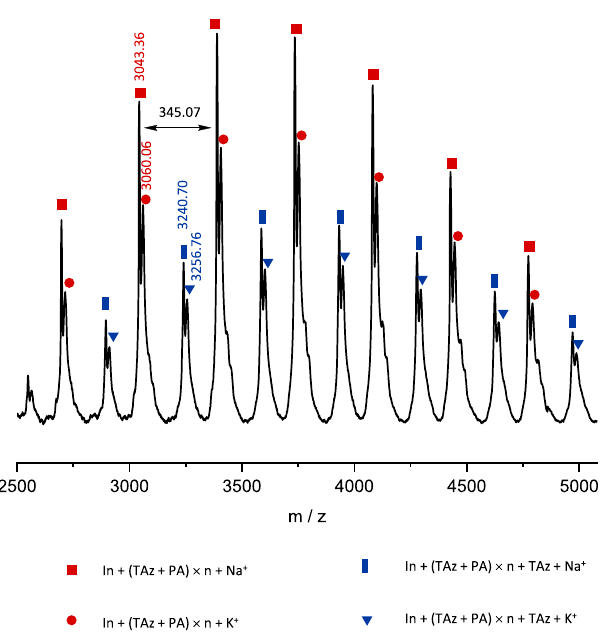
Fig. 5 MALDI-ToF characterization. MALDI-ToF MS spectrum of the fi rst- stage copolymer poly(TAz- alt -PA).